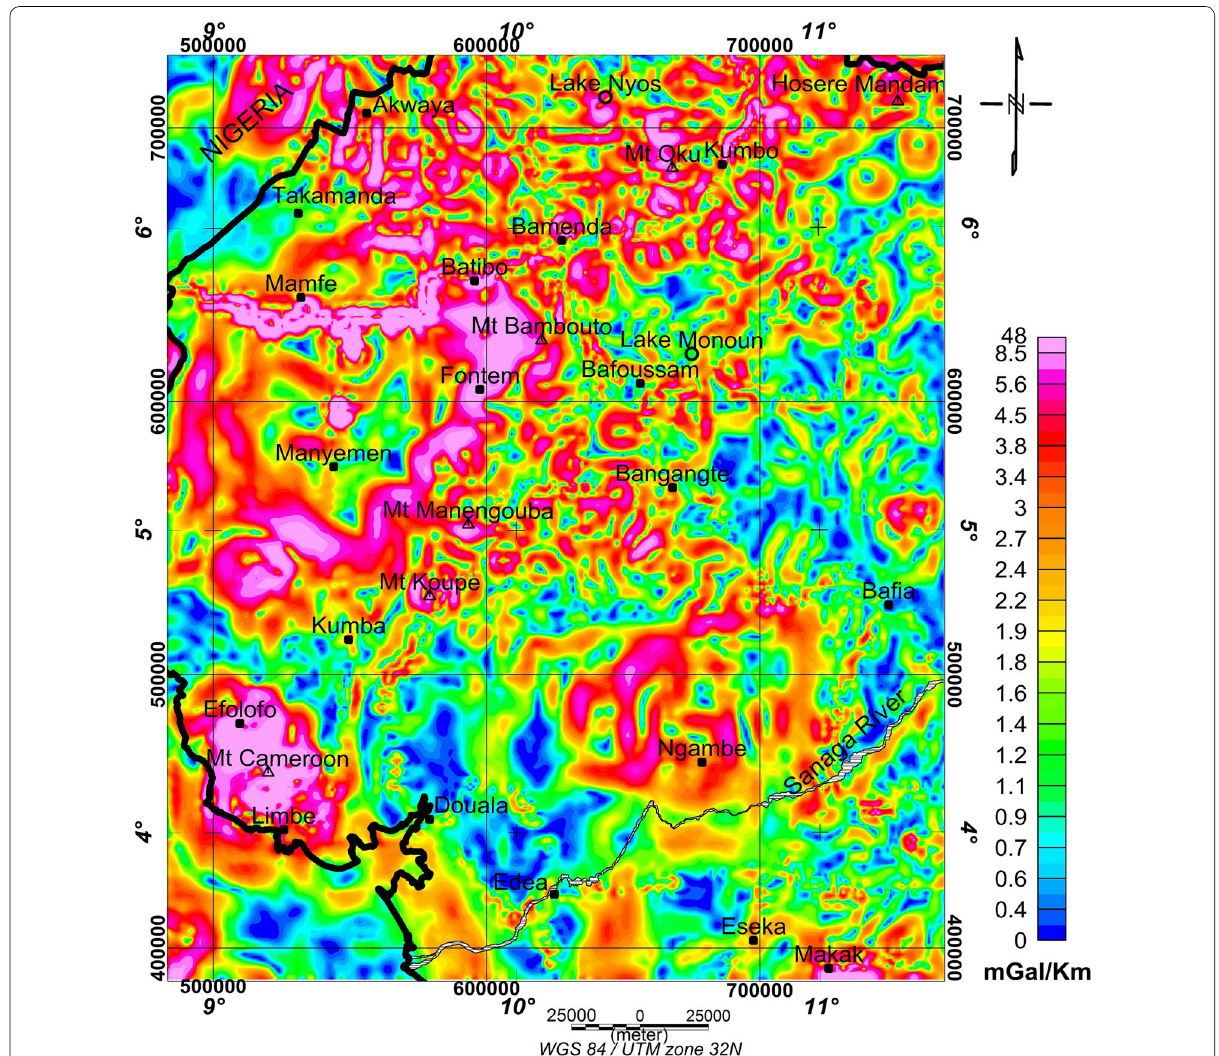
Fig. 7 Horizontal gradient map of the study